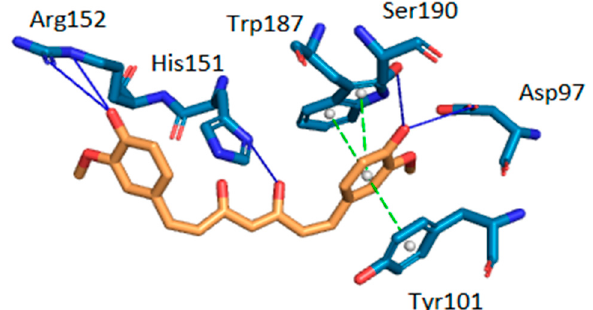
Figure 3. Intermolecular interactions between curcumin and the binding site of human folate receptor β (FR- β ). Carbon atoms of curcumin are shown in orange and carbon atoms of amino-acid residues in light blue color. Oxygen atoms are red and nitrogen atoms dark blue. Hydrogen bonds are depicted in dark blue, π -stacking interactions in green. Hydrogen atoms are omitted for reasons of clarity.